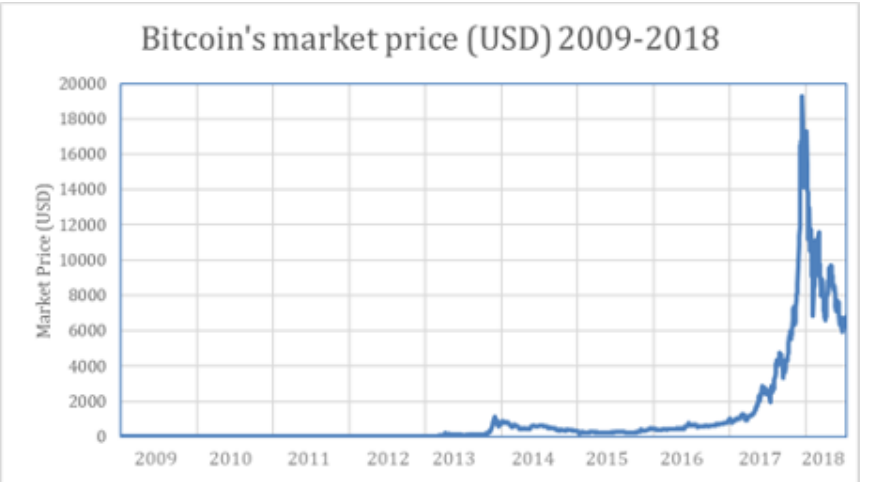
Figure 1: Bitcoin’s market price 2009–2018 (source: Own elaboration based on data collected on